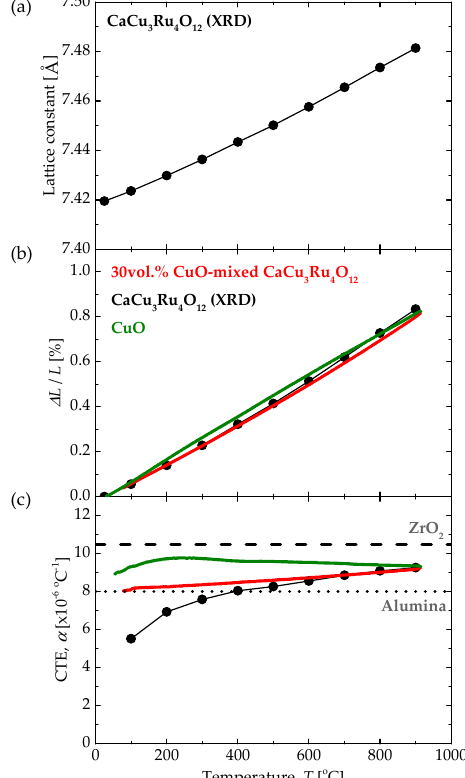
Figure 3. ( a ) Lattice constant of CaCu 3 Ru 4 O 12 as a function of temperature. ( b ) Temperature dependence of Δ L / L 25 and ( c ) temperature dependence of the CTE of the 30 vol. % CuO-mixed CaCu 3 Ru 4 O 12 bulk, CuO bulk, and CaCu 3 Ru 4 O 12 samples. Data for the 30 vol. % CuO-mixed CaCu 3 Ru 4 O 12 bulk and CuO bulk were measured using a thermomechanical analyzer (TMA), while those for CaCu 3 Ru 4 O 12 were calculated from powder XRD.